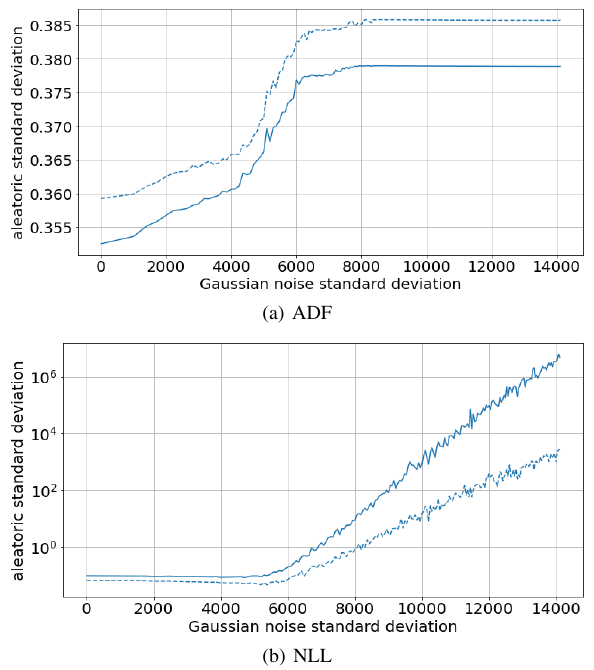
Figure 9. Aleatoric standard deviation estimates of (a) ADF and (b) NLL in pixel units on the noise